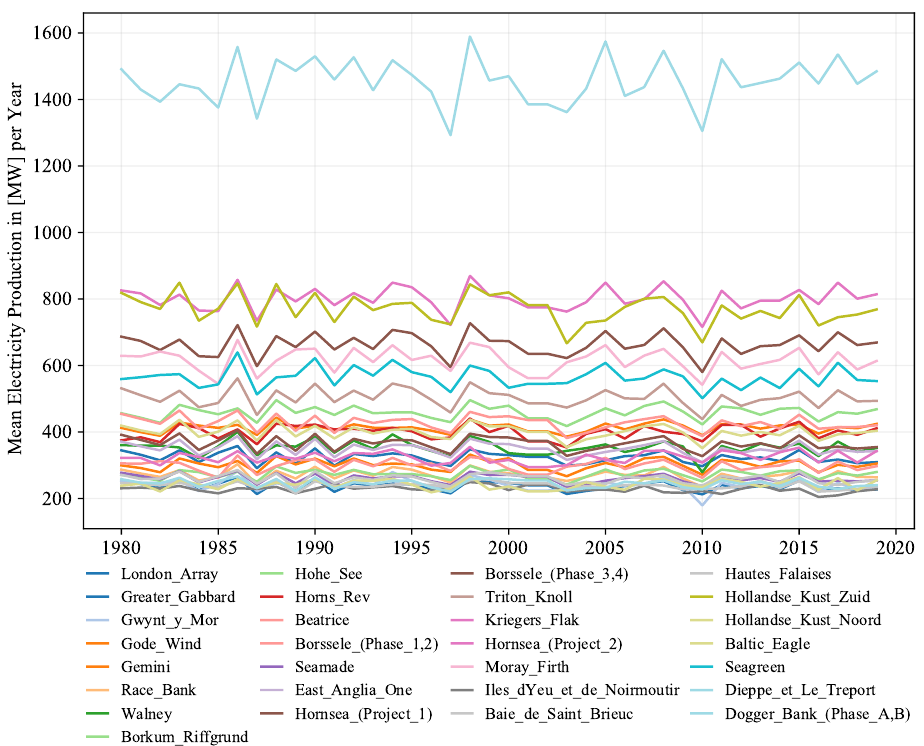
Figure A3. Mean production of all wind farms from 1980 to 2019. Every line illustrates the mean production of one wind farm.